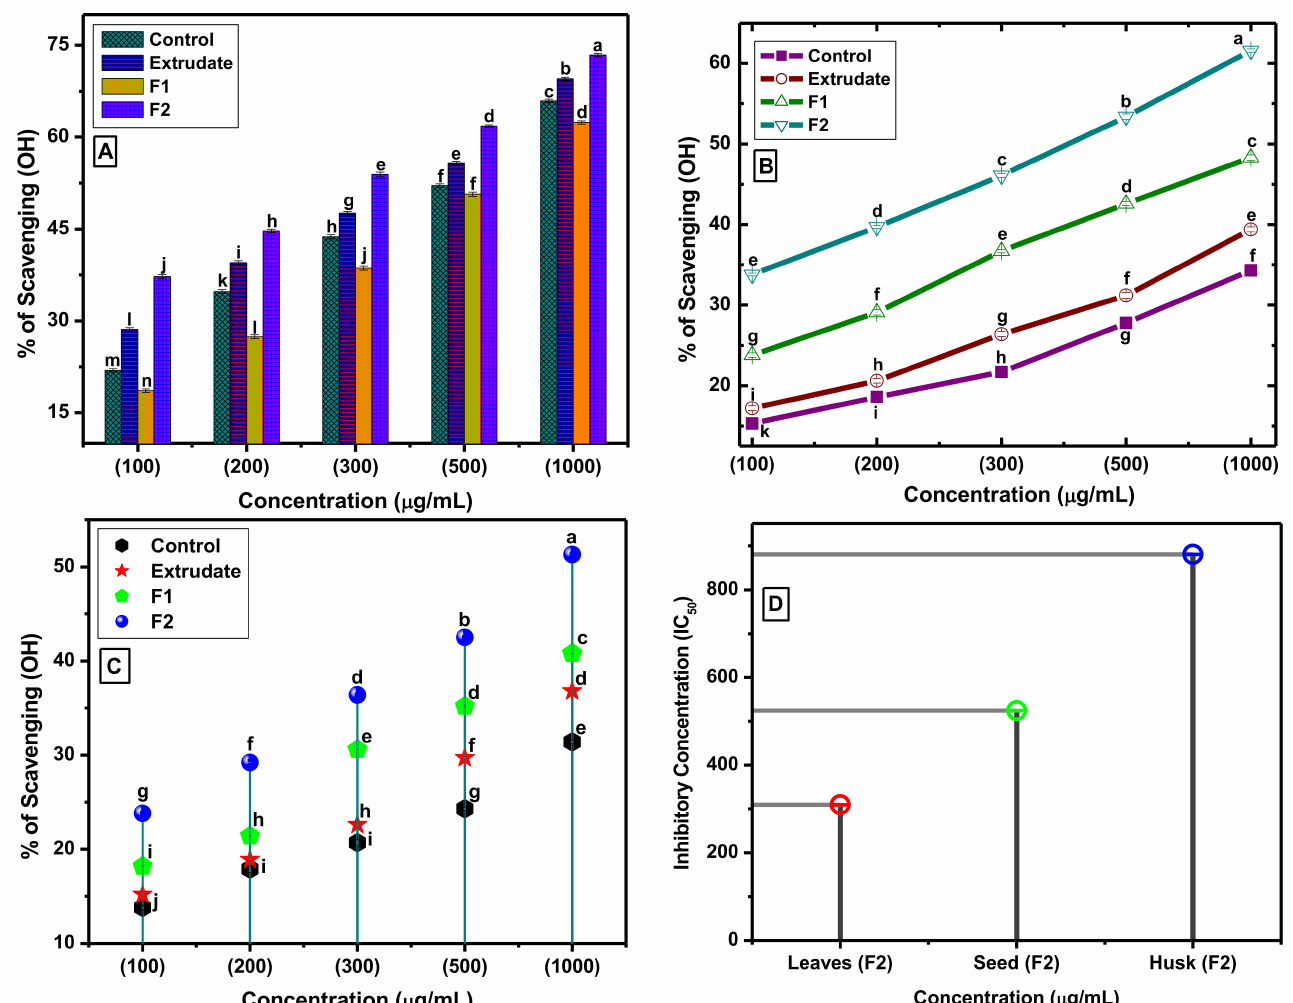
Figure 2. Hydrogen peroxide free radical scavenging capacity. ( A ) Moringa leaves composites (MLC), ( B ) moringa seed composites (MSC), ( C ) moringa husk composites (MHC), and ( D ) inhibitory concentration (IC 50 ) of F2. Mean ± SD from triplicate separated experiments are shown. Values expressed by different letters in each column are significantly different in the t -test ( p <